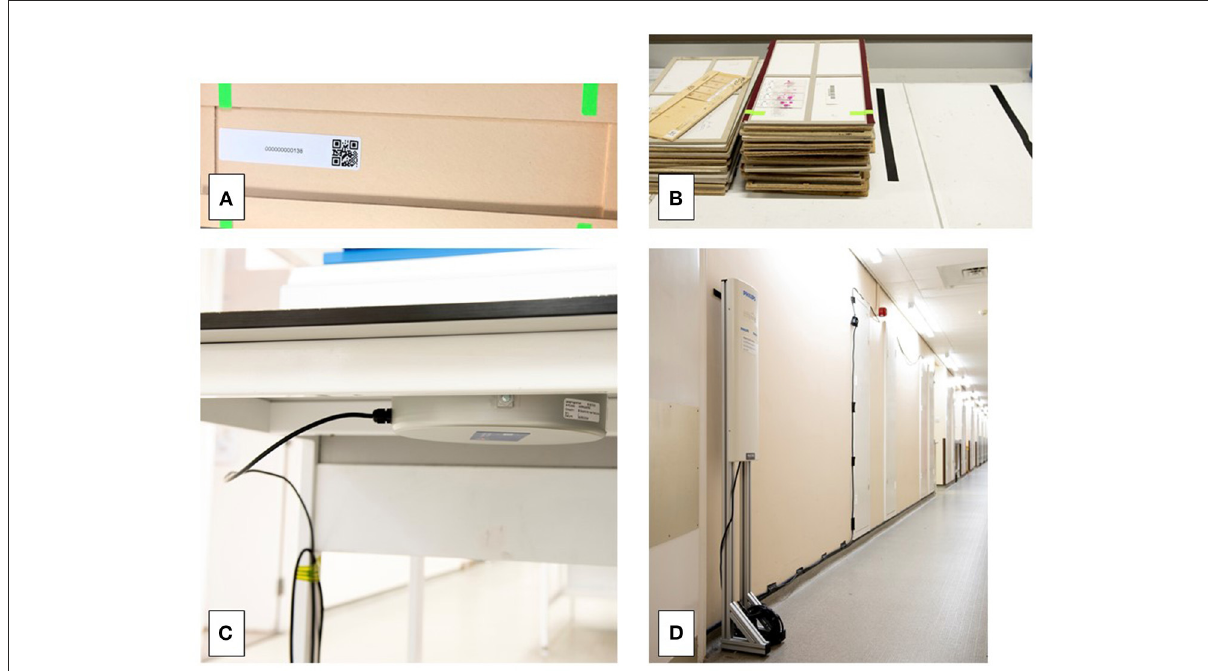
FIGURE2 RFID tags attached to individual slide trays (A) , each tray designated for a single case. Tags could be detected by the RFID reader even when within piles of trays (B) . The position of the table top RFID reader (under the bench, see C ) was indicated to the biomedical scientists by the placement of tape, within the bounds of which the tray was placed in order to “register” it (D) . This set up was present at the start and end point of the study at the sign-out bench and the filing final, respectively. Placement of RFID readers was on the basis of the process mapping of the workflow. The reader in D is that by the pigeon hole doors, placed to capture the movement of cases from the laboratory to the pigeon holes which was the point at which they were available to the pathologist. RFID, radiofrequency